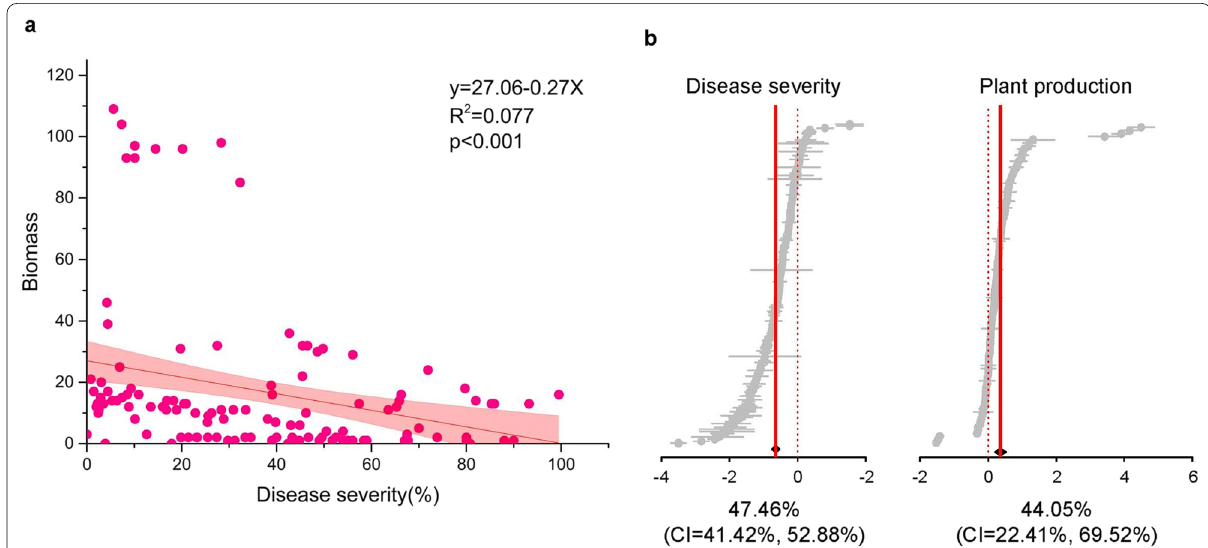
Fig. 1 Influence of disease severity on biomass ( a ) and forest plots of effect size estimates for disease severity and plant production, respectively ( b